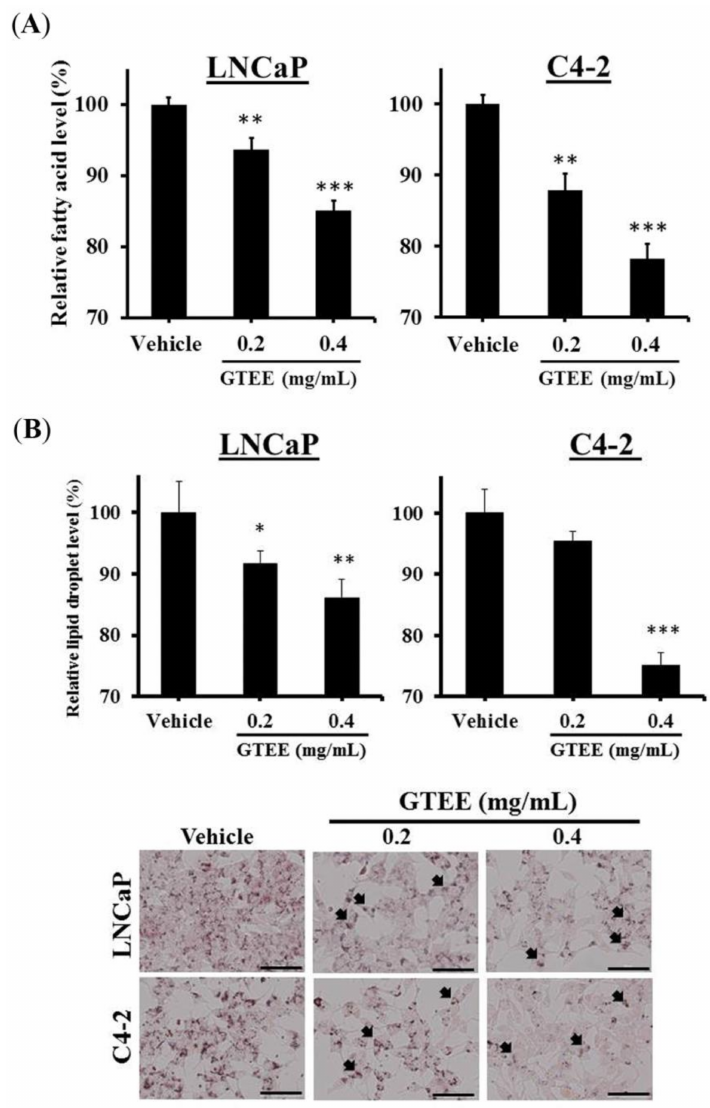
Figure 2. GTEE reduces the amounts of intracellular fatty acid and lipid accumulation in PCa cells. ( A ) LNCaP and C4-2 cells were treated with vehicle (0.3% ethanol) or GTEE (0.2 or 0.4 mg/mL) for 24 h. The levels of intracellular fatty acid were determined by a fatty acid quantification kit. The relative fatty acid level (%) was assigned as 100% in vehicle-treated PCa cells. Data were shown as the mean ± SD of three independent experiments. ** p < 0.01, *** p < 0.001. ( B ) GTEE decreased the amounts of lipid droplet accumulation assayed by the Oil Red O staining in LNCaP and C4-2 cells at 24 h. The relative lipid droplet level (%) was assigned as 100% in vehicle-treated cells. Data were shown as the mean ± SD of three independent experiments. * p < 0.05, ** p < 0.01, *** p < 0.001. The arrowheads indicate lipid droplets in PCa cells (bottom panel). Scale bars = 100 µ